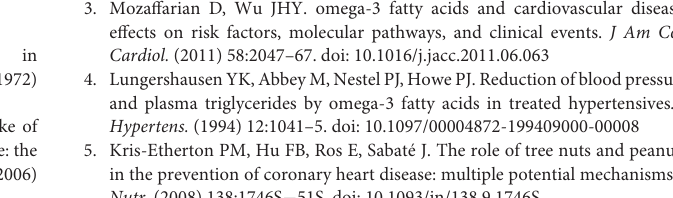
Supplementary Figure S1 | Comparison of omega-3 FA supplementation vs. control group on the risks of stroke and revascularization. Supplementary Table S1 | PRISMA